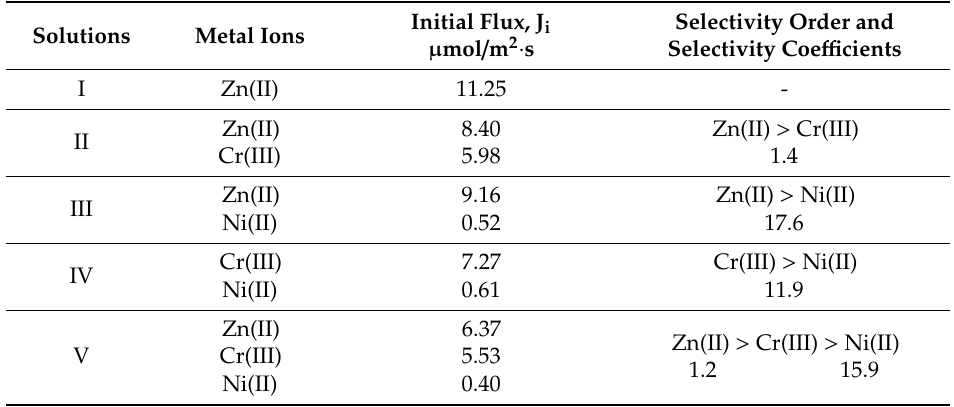
Table 4. Initial fluxes, order and separation coe ffi cients for competitive transport of Zn(II), Cr(III) and Ni(II) ions through membrane doped with EDAB-acac. Conditions as in Figure